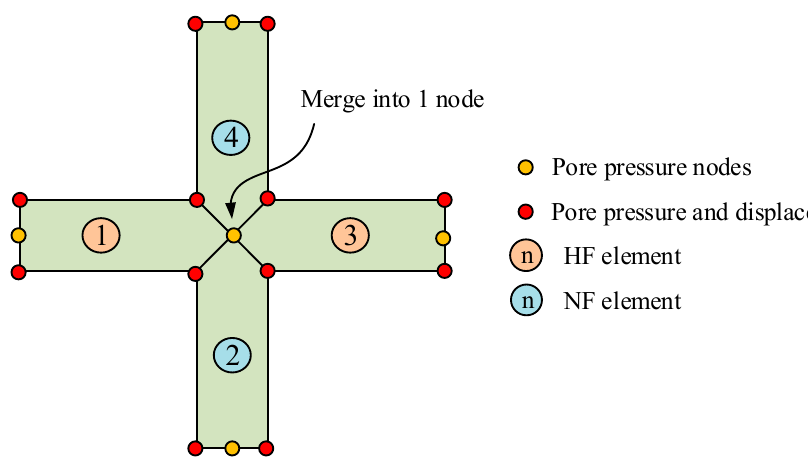
Figure 5. Schematic of element nodes at the intersection.